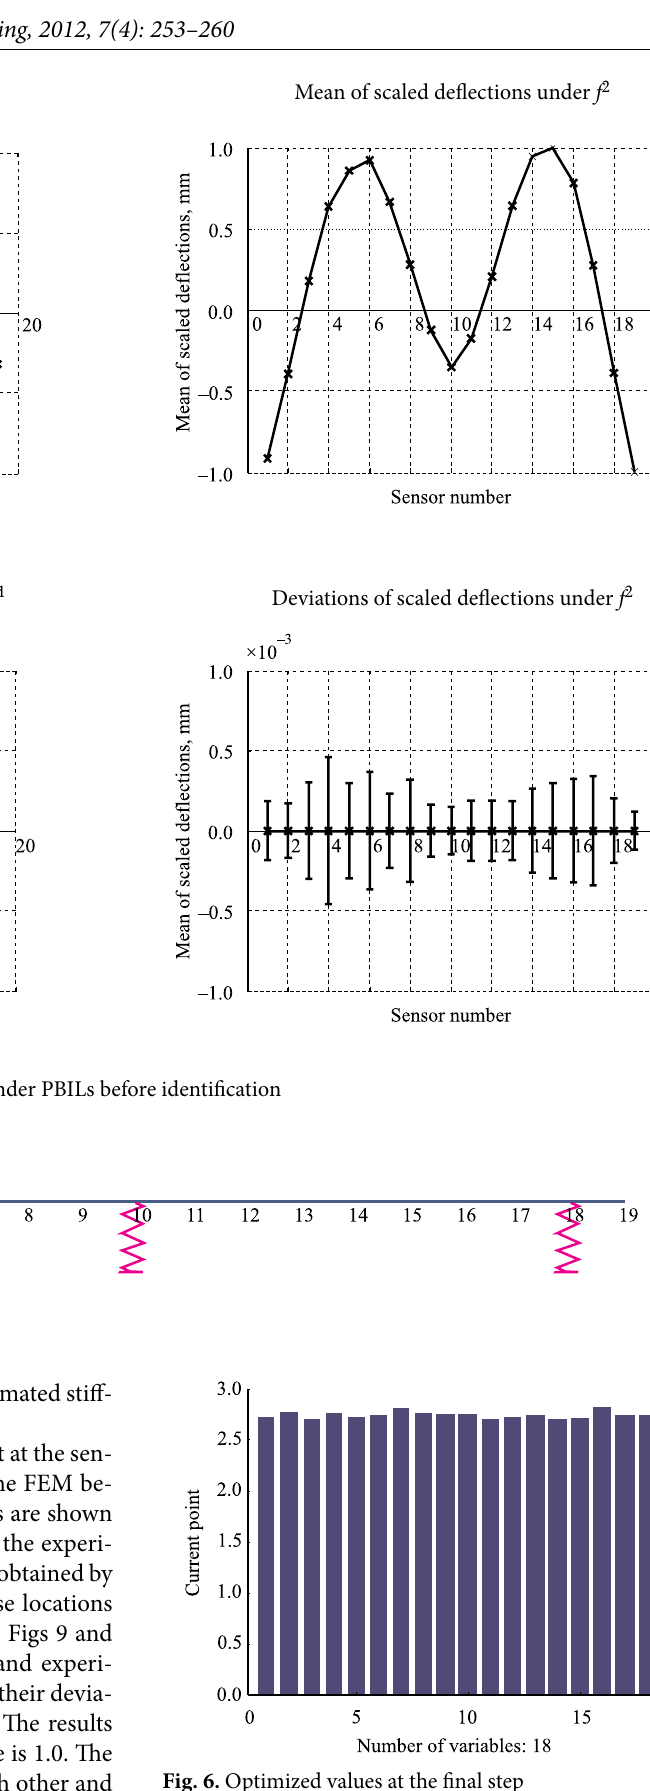
Fig. 6. Optimized values at the final